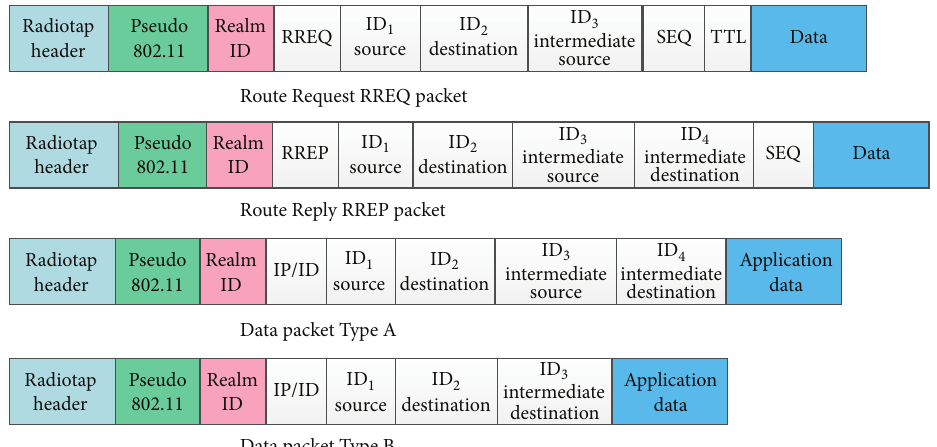
Figure 10: IDHOCNET frames structure.